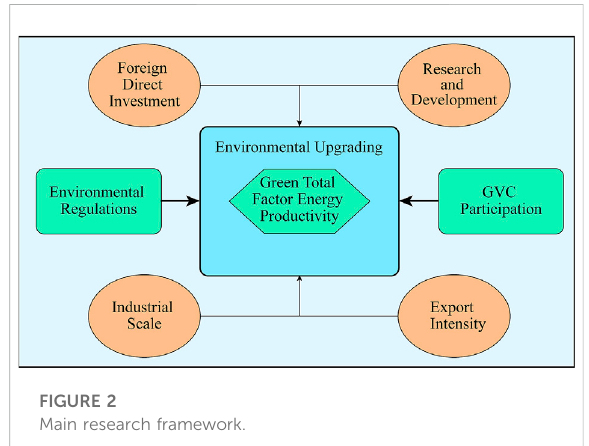
FIGURE 2 Main research